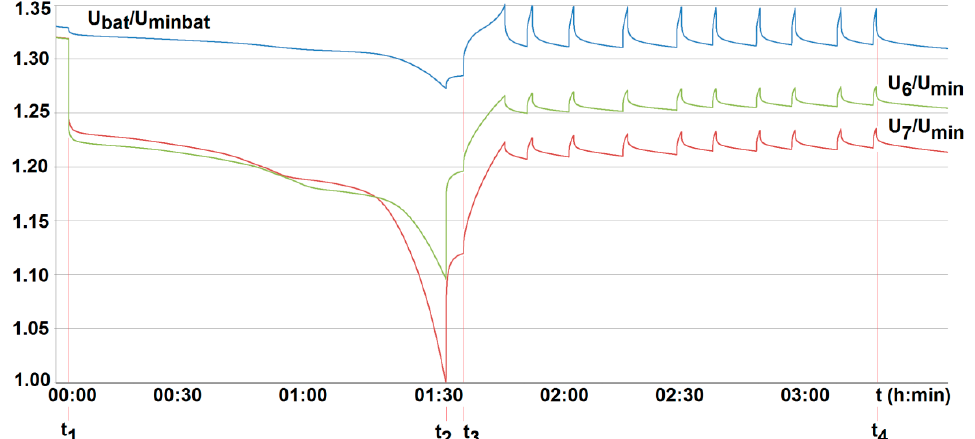
Figure 18. The voltage U 6 /U min and U 7 /U min variation with time for two series-loaded cells (cells no. 6 and no. 7—see Figure 14) of the unburdened battery with the BMS using the battery-to-cell method (room temperature T 0 = 20 °C, free cooling, t 1 , t 2 —moment of switching on and off the load current of 2.5 A, U min —minimum cell voltage equal to 2.5 A, U minbat —minimum battery voltage 20 V, U bat —battery voltage (maximum 29.2 V), t 3 , t 4 —switching on and off the passive balancing.